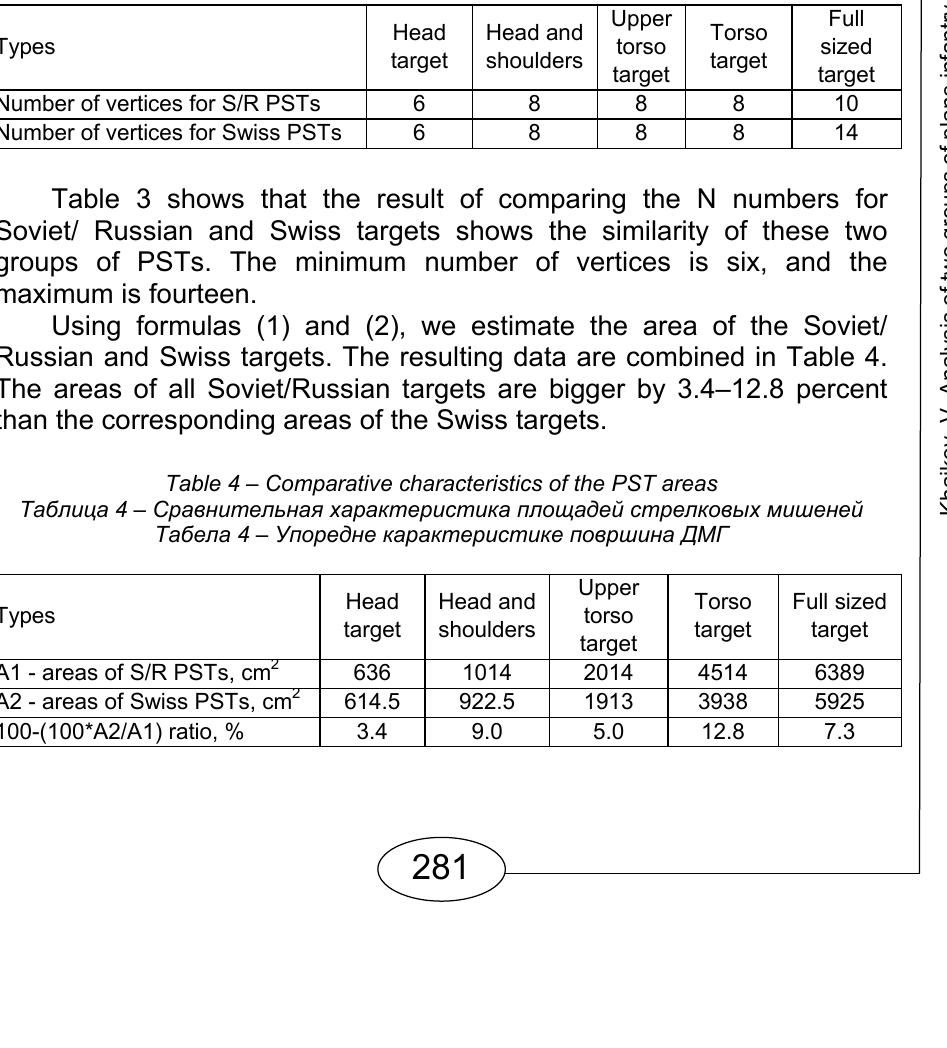
Table 3 – Comparative characteristics of the number of vertices for PSTs